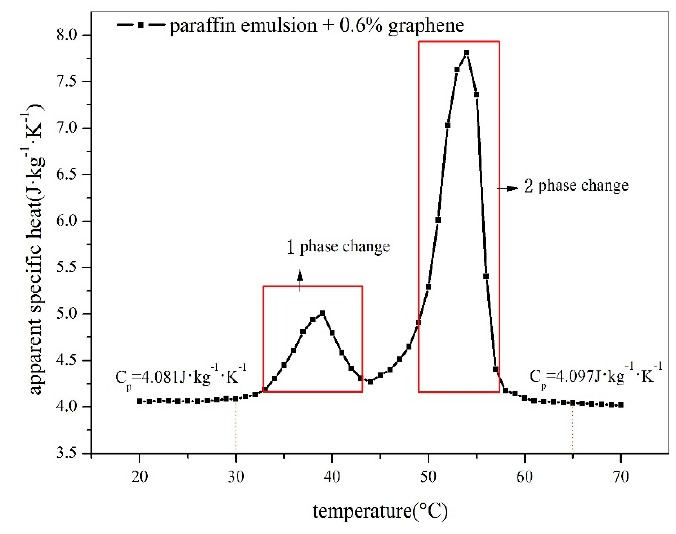
Figure 1. The specific heat change trend during the melting process.